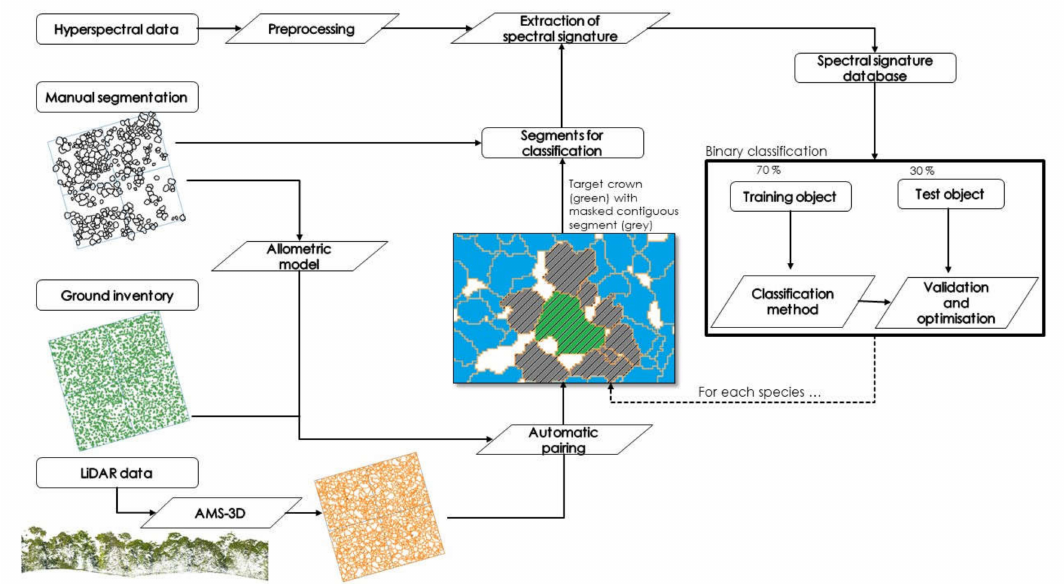
Figure 1. General methodological outline illustrated for a sample plot. The inventory data (green points) are paired with the automatically segmented crown (orange outline). Pairing is based on an allometric model developed from manually segmented crowns (black outline). In the segmented and colorized image, the green segment is one potential crown of the focal species; in grey, the neighbouring crowns that are also masked to make sure all pixels of the focal class are removed (striped segments) from the data set; in blue, the crowns